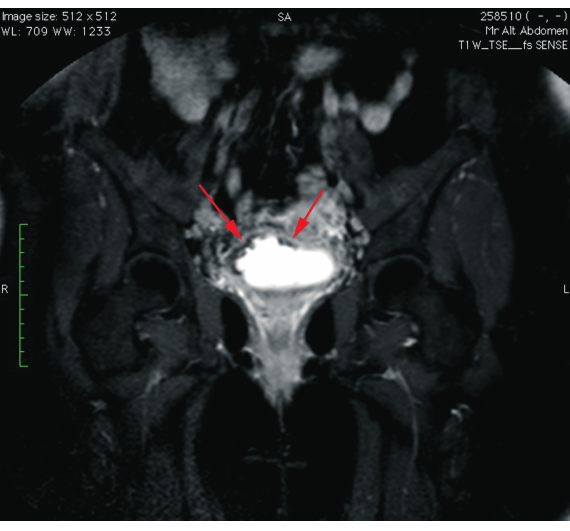
Figure 2 - Coronal magnetic resonance image of bladder demonstrating filling defects (arrows) of right bladder